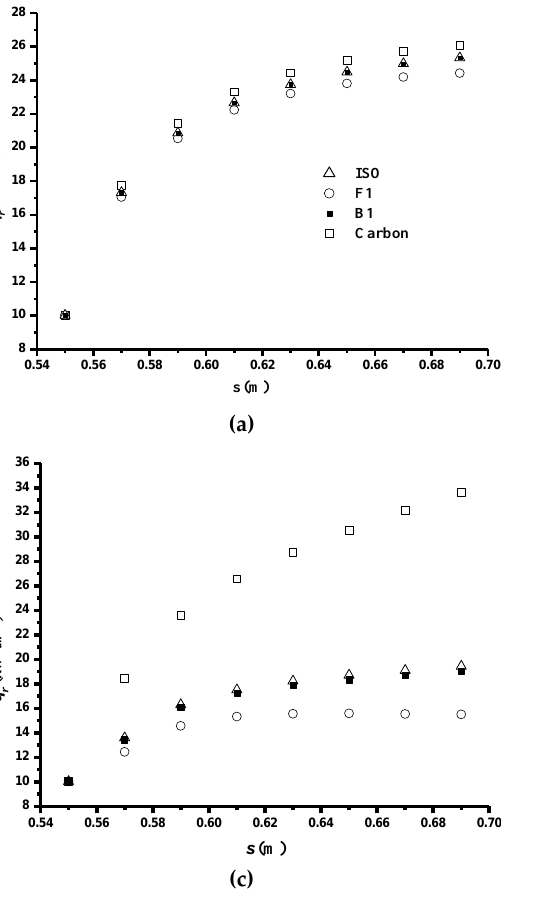
Figure 9. Distributions of the net radiation heat flux density profils on the walls of the left pyrolysis room ( z = 0.6 m, κ = 1 m − 1 ): ( a ) ω = 0.1, ( b ) ω = 0.5, ( c ) ω = 0.9.